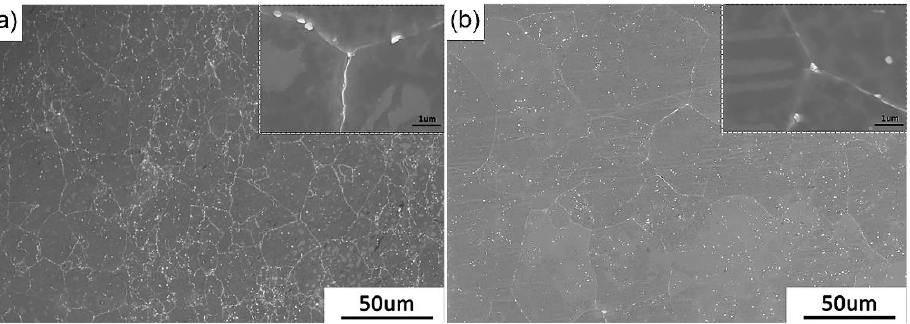
Figure 4. SEM images of the Mg-6Al plate ( a ) as-rolled and ( b ) annealed at 300 °C. Corresponding high-magnification images are shown in the insets.